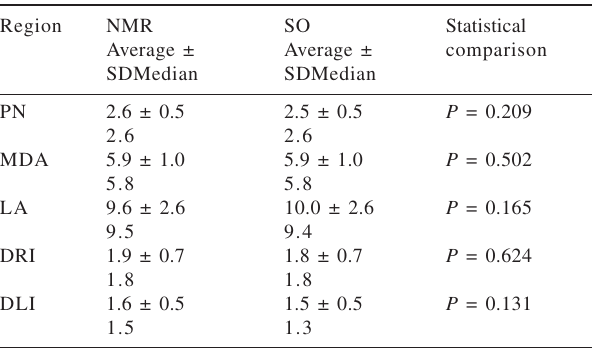
Table 4 - Comparison between nuclear magnetic resonance (NMR) measurements and surgical observation (SO) (n = 20).